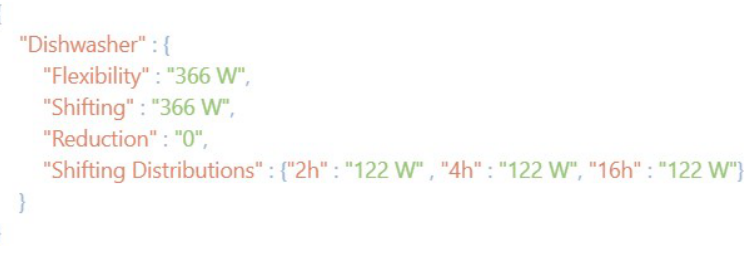
Figure 3. Shifting Distributions of end-user 2 to the demand response event at 11 h. The graph of Figure 3 shows the shifting planning of IoT devices referring to end- user 2 that have flexibility during the event. However, the end-user owns more IoT de- vices, but not all of them are represented in the graph since they have no flexibility during the DR event. The respective period where the DR event is applied is the 11:00 a.m. period, where a reduction in the EC consumption by around 1.55 kWh is necessary. Regarding the rank- ing of the IoT devices to participate in the DR event, this paper considers the four metrics mentioned in Section 4.2. 6. Results and Discussion After the implementation of the methodology presented in Section 4, the ranking of the IoT devices is obtained, as can be seen in the example illustrated in Table 2. This table shows the score of the top 10 ranked IoT devices for each metric, described in Section 4.2., and on the total. The IoT devices are represented by “D[e].[d]”, where e represents the ID of the end-user and d represents the ID of the IoT device in the residence of the end-user. Metrics 1 and 2 assess, respectively, the IoT device’s participation and flexibility regarding past DR events. While Metric 3 and 4 assess the flexibility of the IoT devices for period 𝑡 . As mentioned before, Metric 3 is only applied in IoT devices that can provide flexibility by reduction and Metric 4 in IoT devices that can provide flexibility by shifting. Therefore, these metrics cannot be applied to the same IoT devices. Since, in this particular case, the